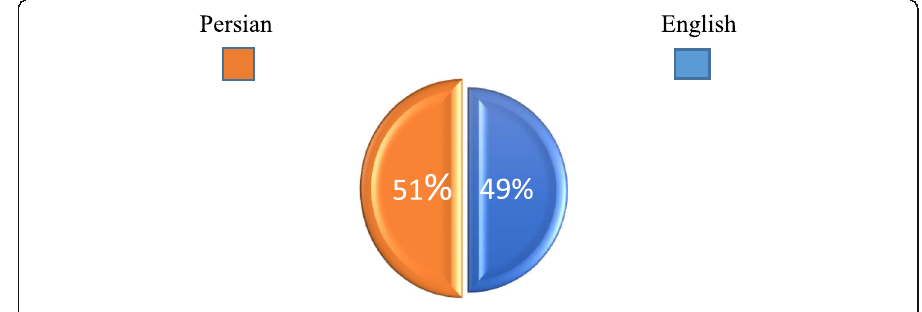
Table 2 Cross Tabulation Results for Different Token of EWs in English and Persian Short Stories Emotive Words